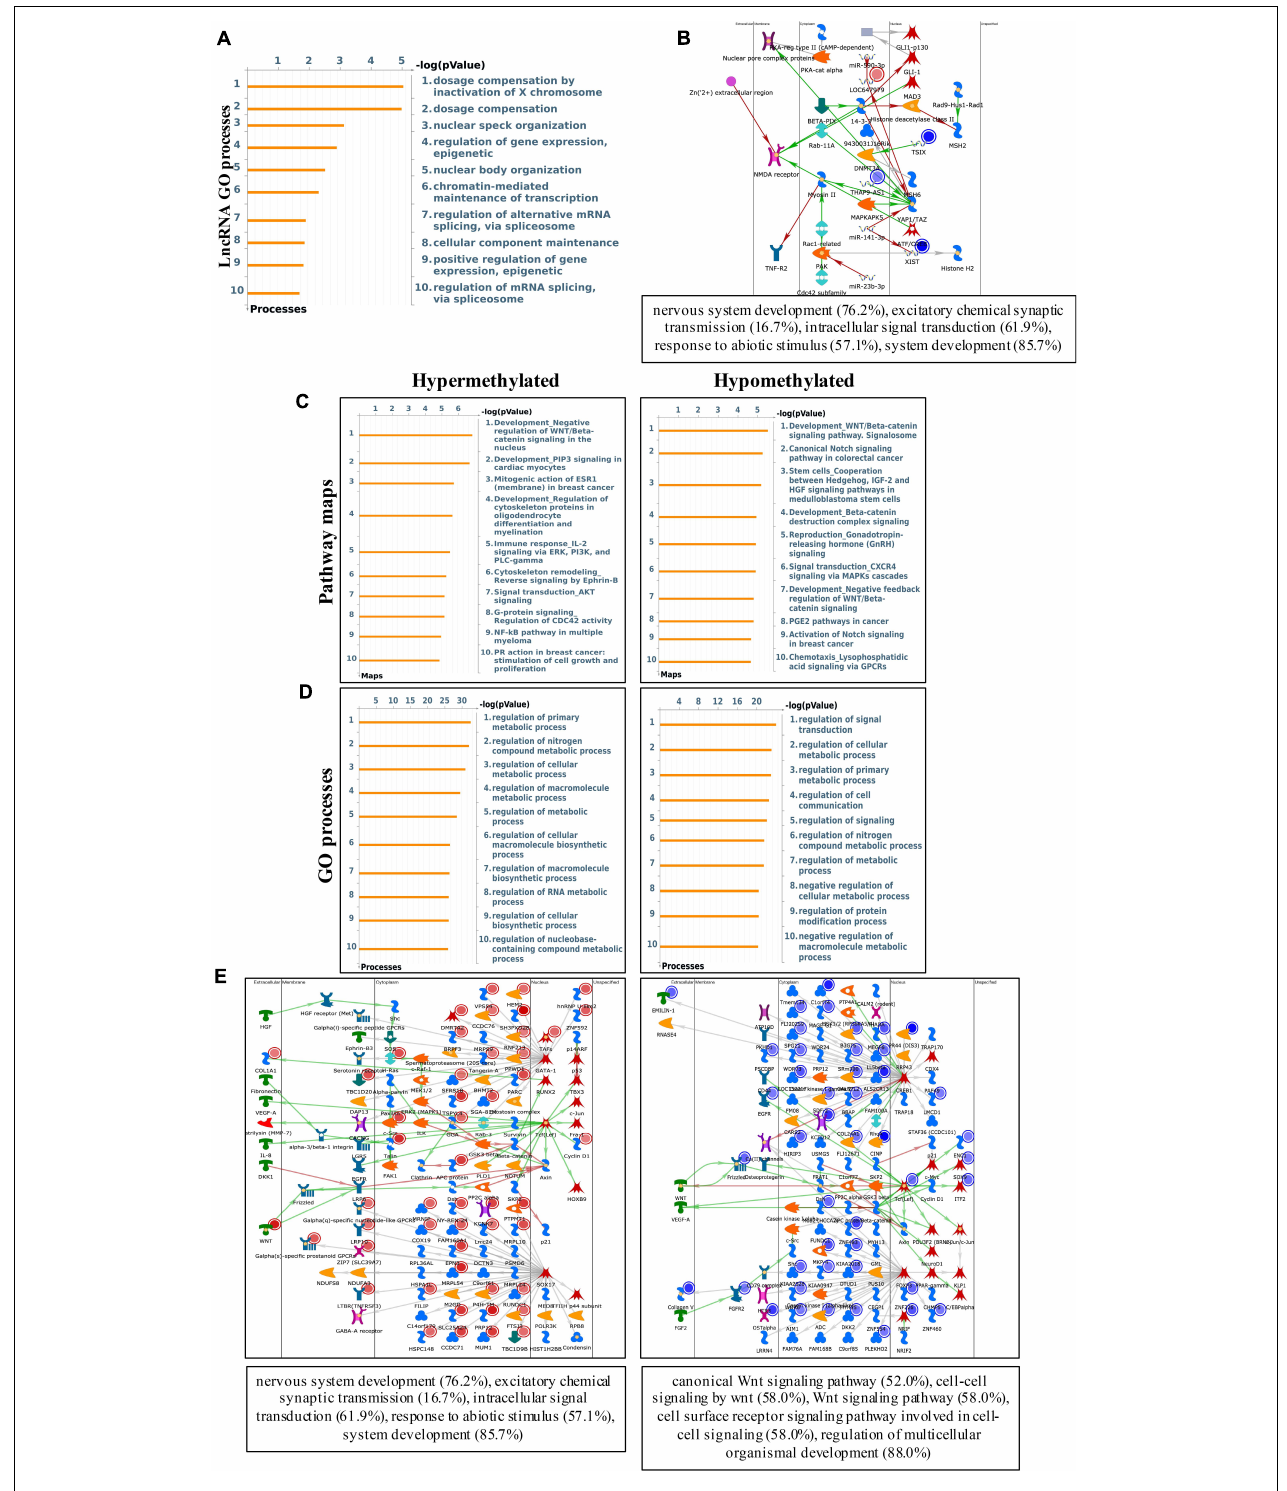
FIGURE 4 | Systematical analyses of differentially methylated mRNA in pterygium. (A) Gene Ontology (GO) processes analysis of differentially methylated lncRNA. (B) Top three scored networks analysis of differentially methylated lncRNA. (C) Pathway maps analysis of differentially methylated peaks. Left panel represents hypermethylated genes and right panel represents hypomethylated peaks. (D) GO process analysis of differentially methylated peaks. Left panel represents hypermethylated peaks and right panel represents hypomethylated peaks. (E) Top three scored networks analysis of differentially methylated peaks. Left panel represents hypermethylated genes and right panel represents hypomethylated